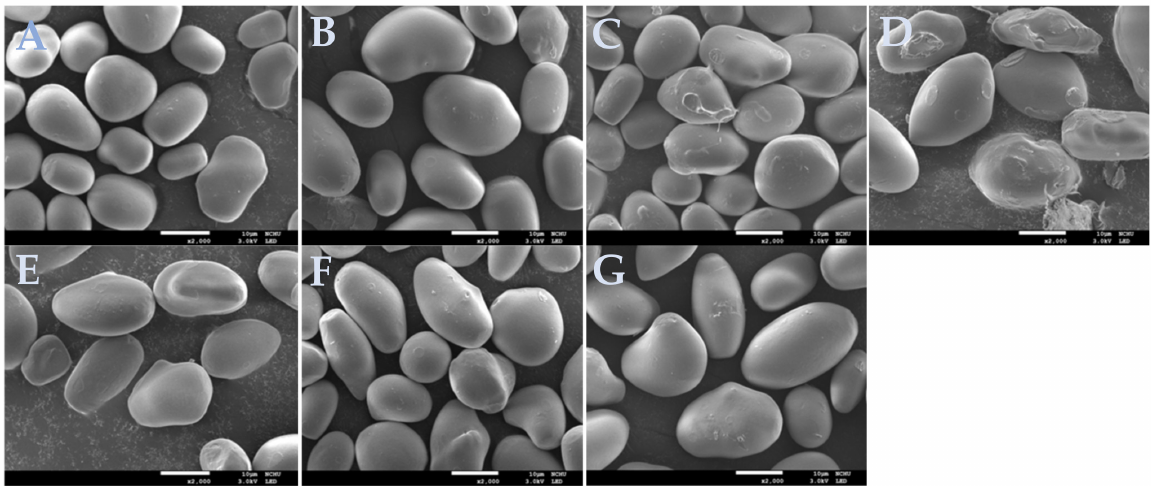
Figure 1. Effect of various hydrothermal treatments on the morphology of water caltrop starch (2000 × ). ( A ) Native starch; ( B ) HMT20; ( C ) HMT25; ( D ) HMT30; ( E ) ANN; ( F ) HMT20 + ANN; ( G ) ANN + HMT20. HMT indicates heat-moisture treatment. The numbers 20, 25, and 30 indicate the moisture level under HMT. ANN indicates annealing.